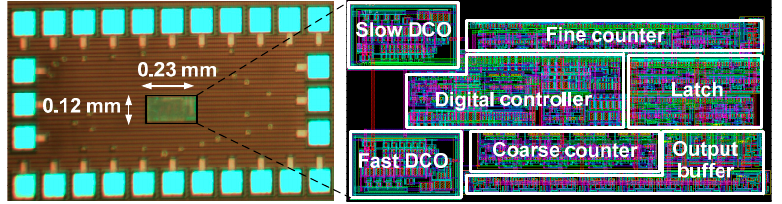
Figure 14. Chip microphotograph of the TDC.